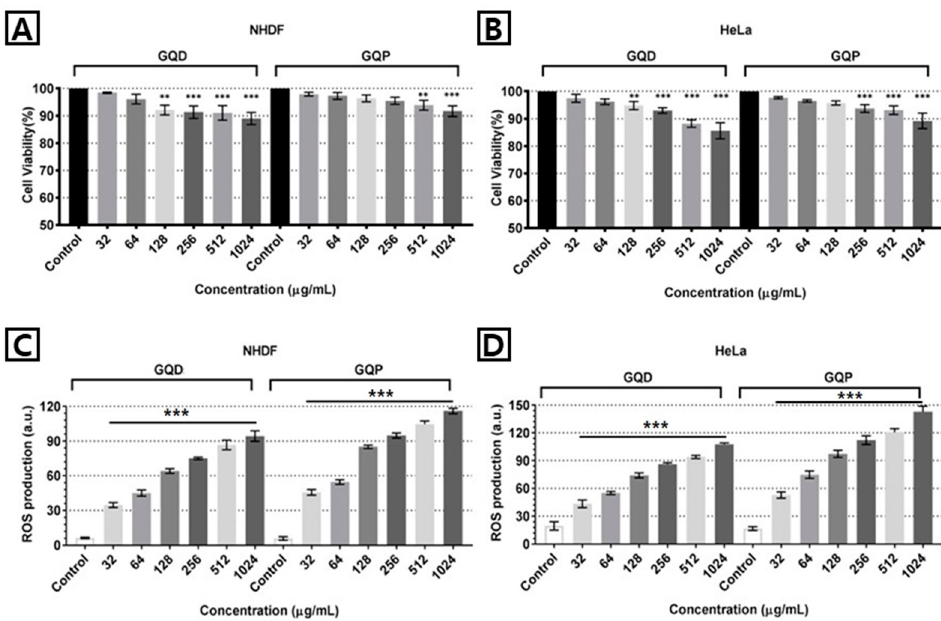
Figure 6. Toxicity of GQDs and GQPs in ( A ) normal human dermal fibroblast (NHDF) and ( B ) HeLa. Cell viability of GQDs and GQPs measured using CCK-8 assay. Experiments were repeated thrice with the triplicate, and significant difference between control and test samples are marked with ** ( p < 0.01), and *** ( p < 0.001). ROS generation level of GQDs and GQPs in ( C ) NHDF and ( D ) HeLa. The level of GQDs and GQPs measured using DCFH-DA assay. Experiments were repeated thrice with the triplicate, and a significant difference between control and test samples are satisfied in all test concentrations.